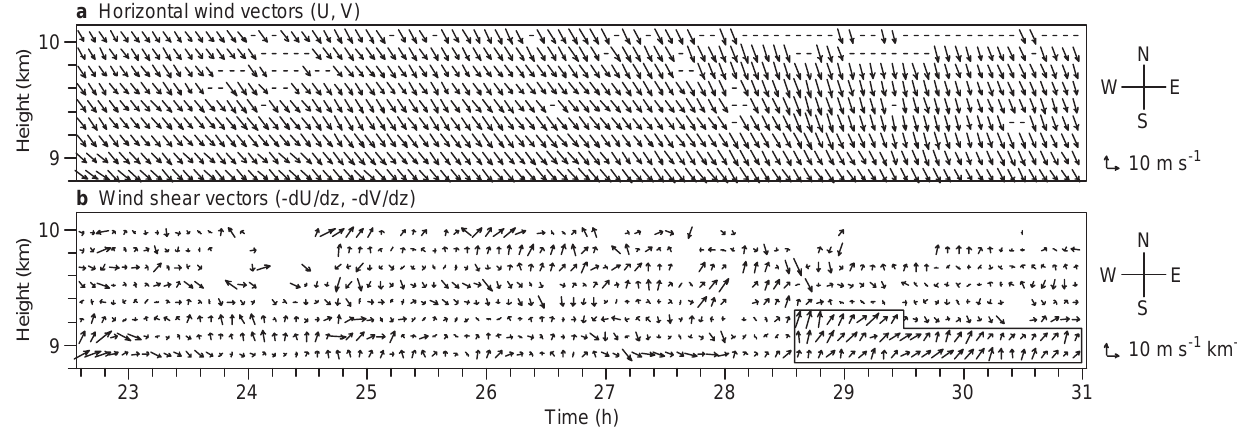
Fig. 2. a Height-time plot of horizontal wind vectors, 2234 LT, 6 July 1998 – 0657 LT, 7 July 1998. b Vectors showing the vertical shears of the zonal and meridional winds. The shear direction is extremely variable, except in the area marked by a box